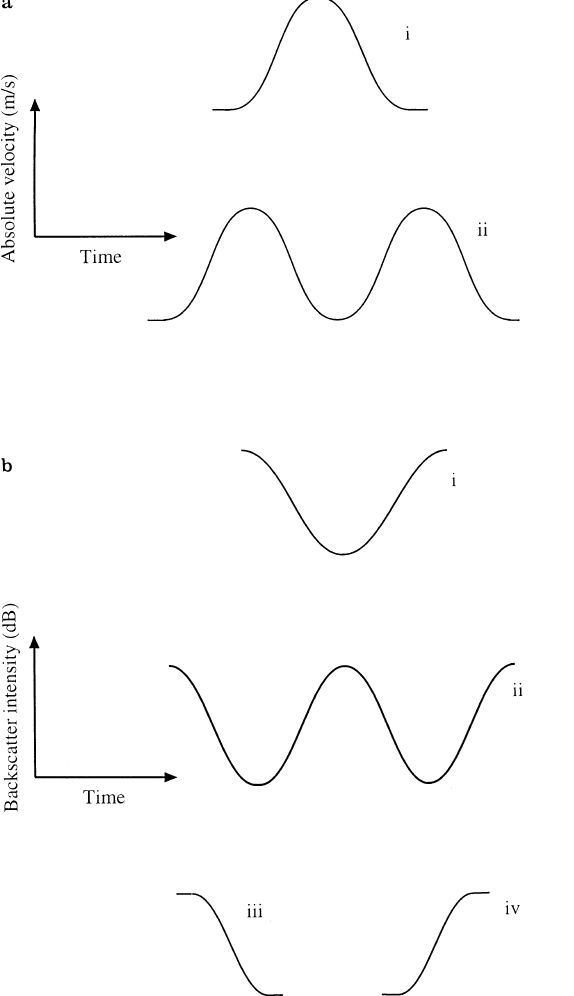
Fig. 2. a Ideal velocity variations employed as fitting function by the search algorithm coded to locate SARAS type events. b Series of ideal backscatter intensity variations employed (see text for details)